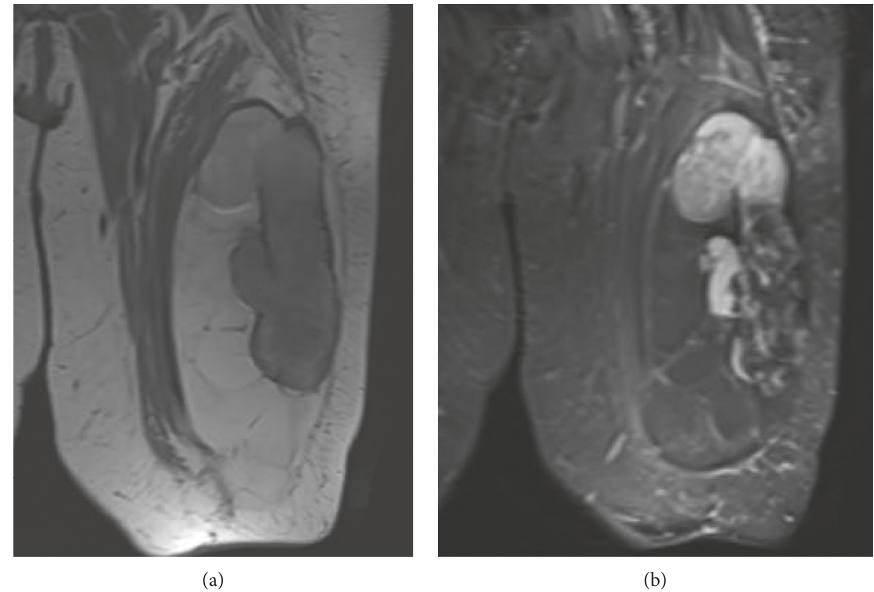
Figure 1: Coronal T1 (a) and STIR (b) MRI of a 30cm diameter ALT/WDL confirmed by MDM2 FISH which is deep to fascia, contains foci of T2 enhancement, heterogeneity, nodularity, and internal cystic